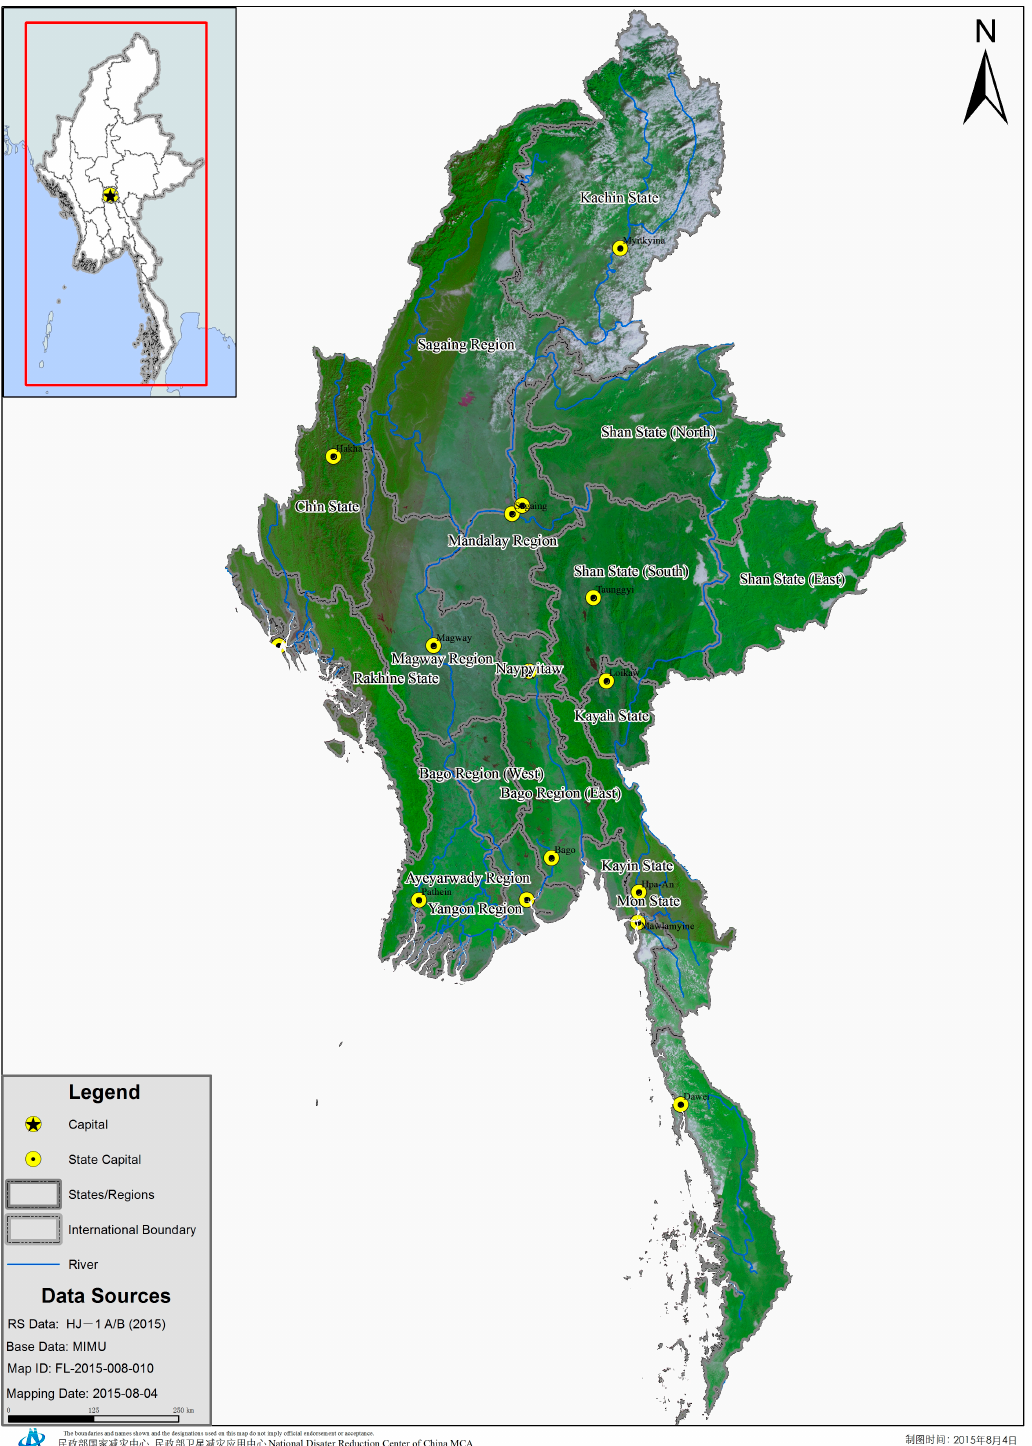
Figure 3. Pre-flood HJ-1A/B Images of Myanmar.